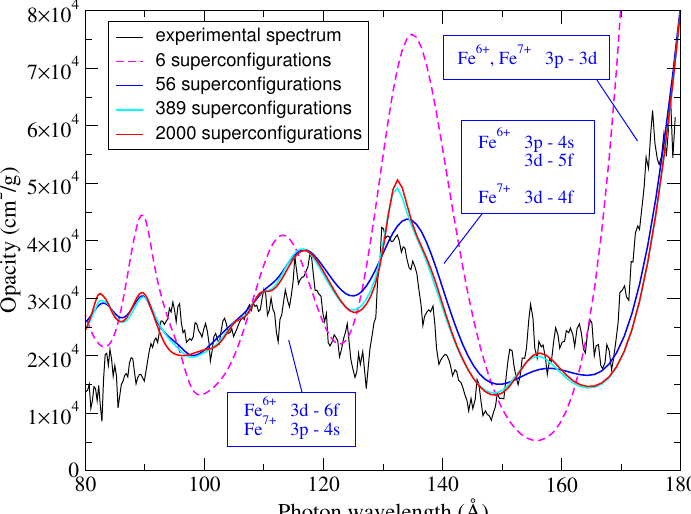
Figure 2. Interpretation of an experimental spectrum measured on ASTERIX IV laser facility (Garch- ing, Germany) by Winhart et al. [9,15,16]. The areal mass of the iron sample is 20 µ g/cm 2 . The best agreement was obtained at a temperature of 22 eV and a density 0.01 g/cm 3 . The calculations have been carried out with 3, 56, 385 and 2000 superconfigurations, corresponding to 2, 3, 4 and 9 supershells